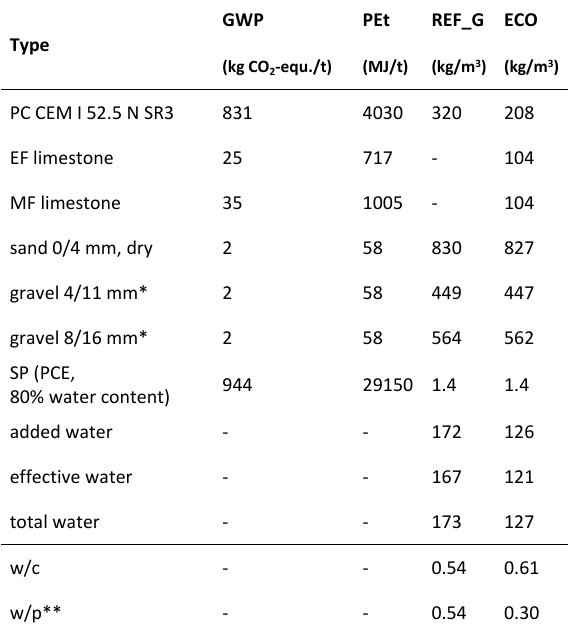
Table 2. GWP, PEt of concrete constituents as well as concrete mix